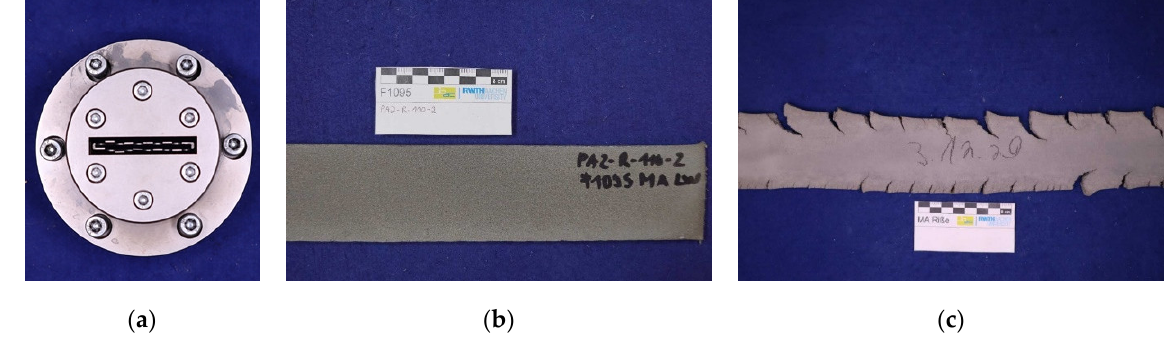
Figure 3. ( a ) Mouthpiece for the extrusion of textile mortar, cross section 60 × 10 mm, ( b ) example of a suitable mixture for the extrusion process, ( c ) example of an unsuitable mixture for the extrusion